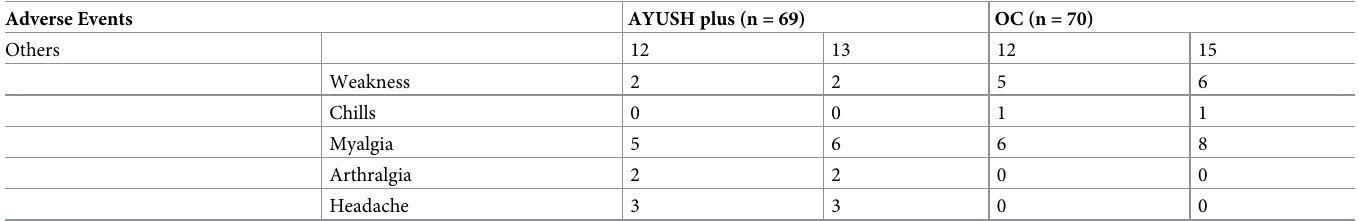
(Table 2) as per the protocol analysis and -3.11 to -0.71 as per the intention-to-treat analysis Table S5.5 in S5 File in favor of the AYUSH plus intervention. The latter was also shown at each study site. A significantly higher proportion of AYUSH plus participants (69.7% versus 51.7%) achieved clinical recovery within the first week after randomization. AYUSH Plus also showed substantial, and often significant, improvement in several secondary efficacy and qual- ity of life measures (Tables 2,